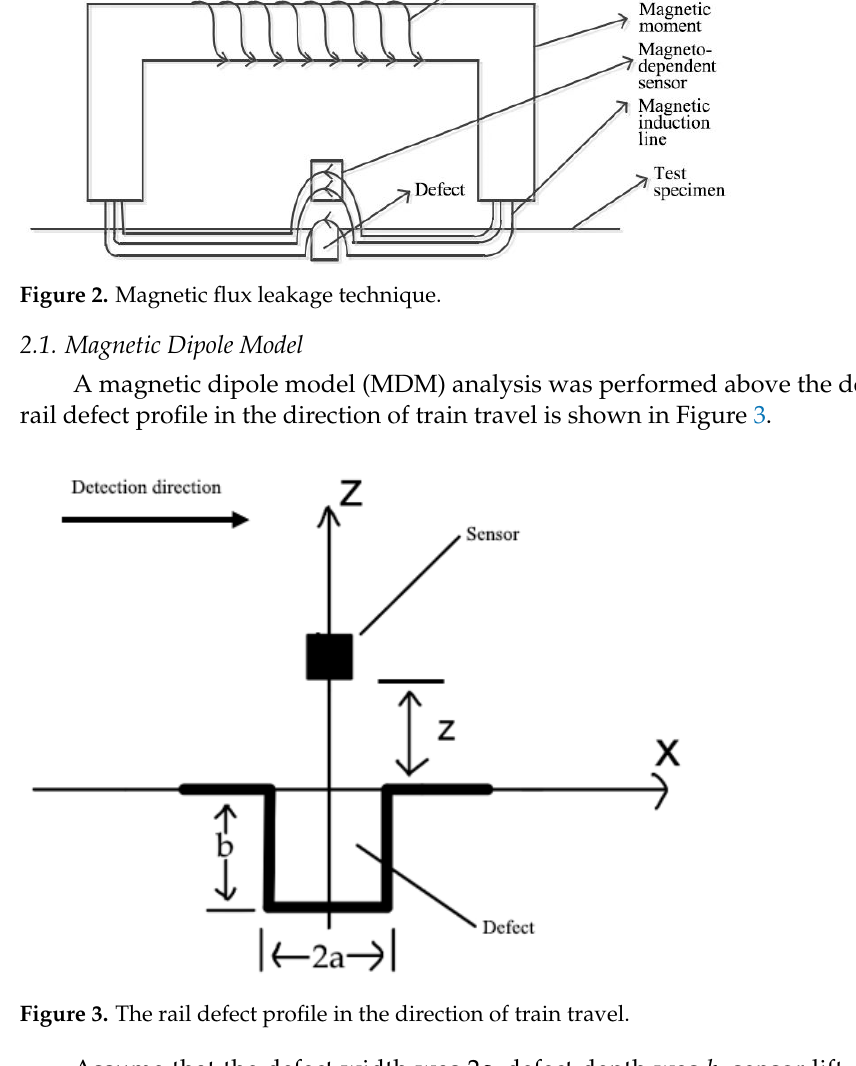
Figure 3. The rail defect pro fi le in the direction of train travel.